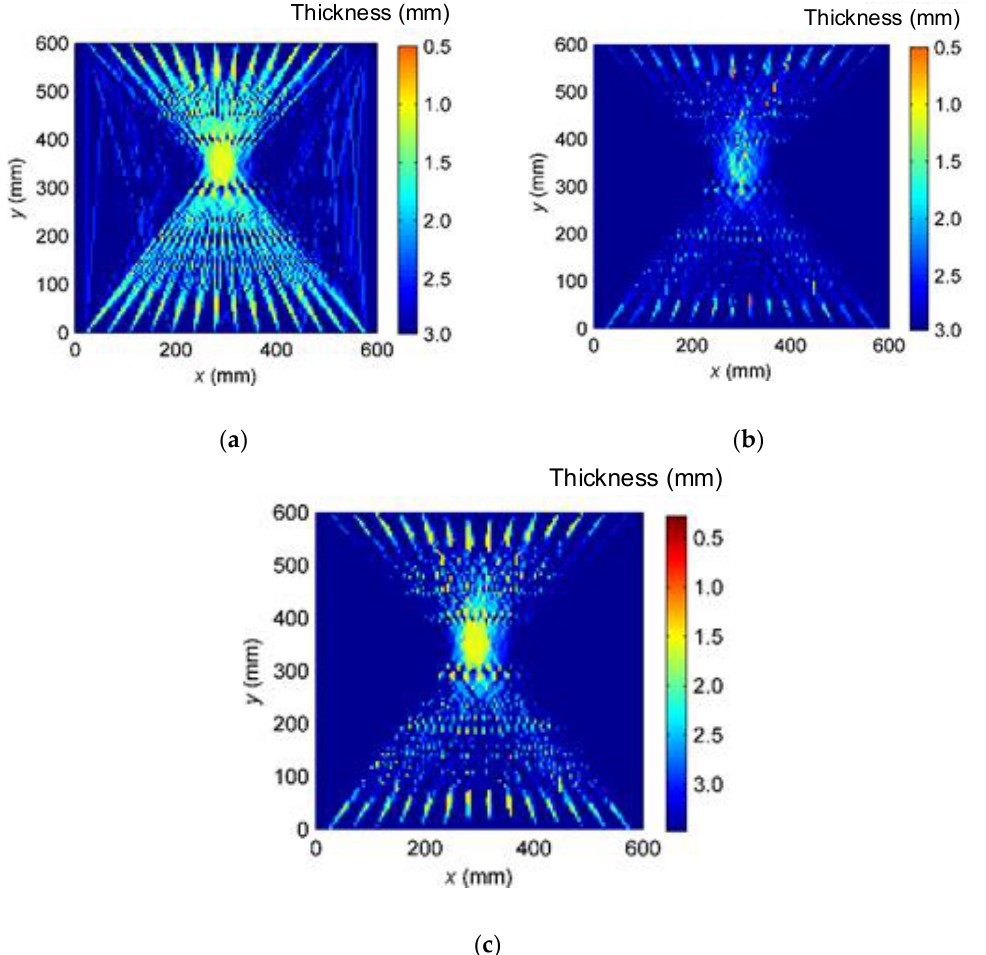
Figure 5. Thickness distribution results of LW CTI. ( a ) Single A0-mode LW CTI; ( b ) single S0-mode LW CTI; and ( c ) multi-mode LW CTI.